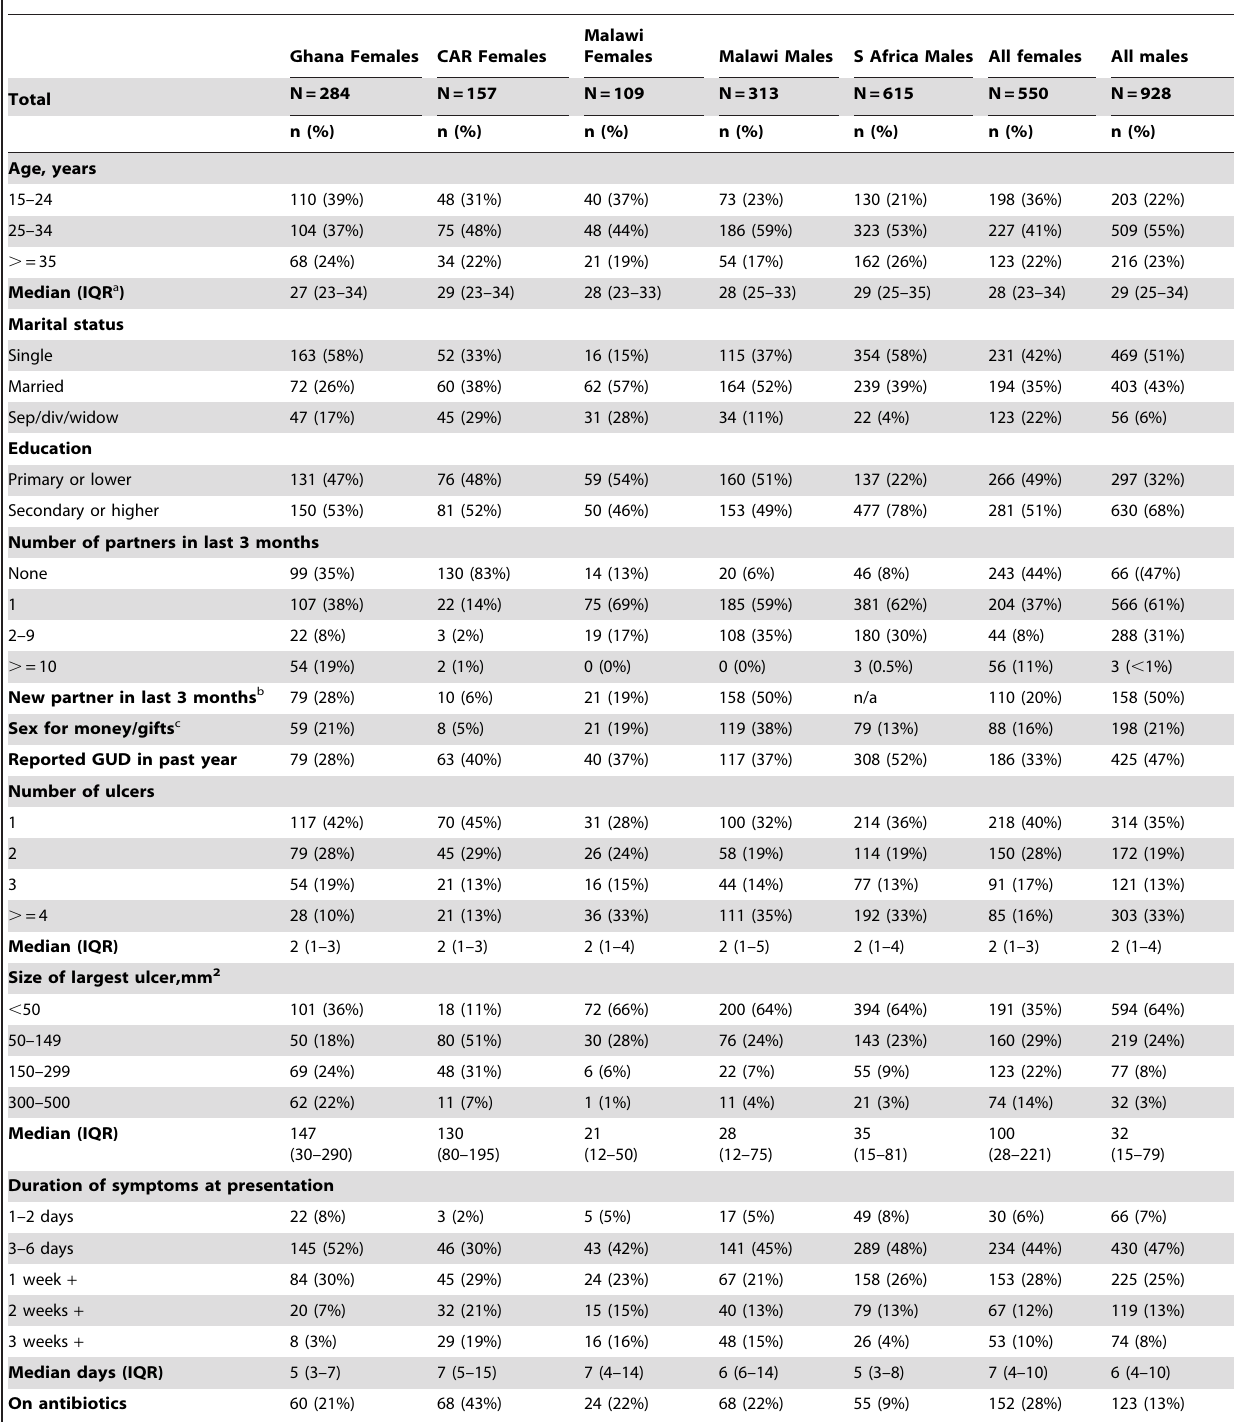
Table 2. Demographic, behavioural and clinic characteristics of 1478 trial participants with genital ulcer disease (GUD) at enrolment, by country and